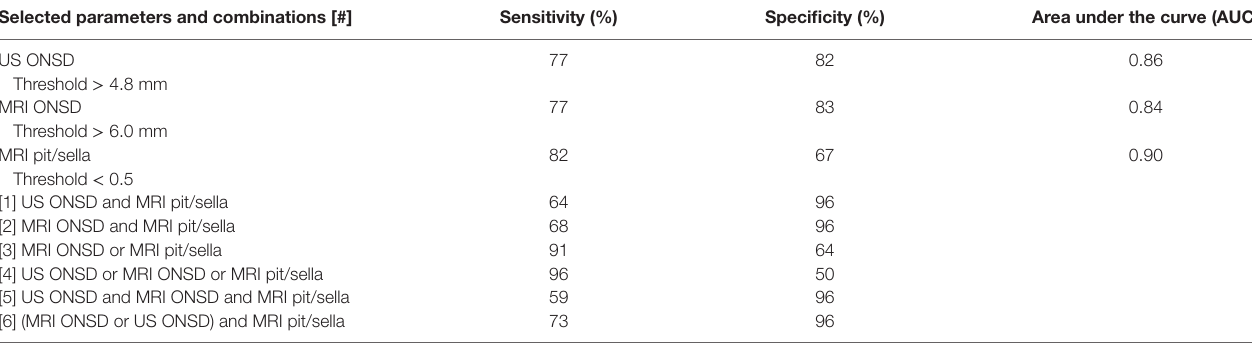
TaBle 3 | Sensitivity and specificity based on combined modality imaging using established thresholds. selected parameters and combinations [#]